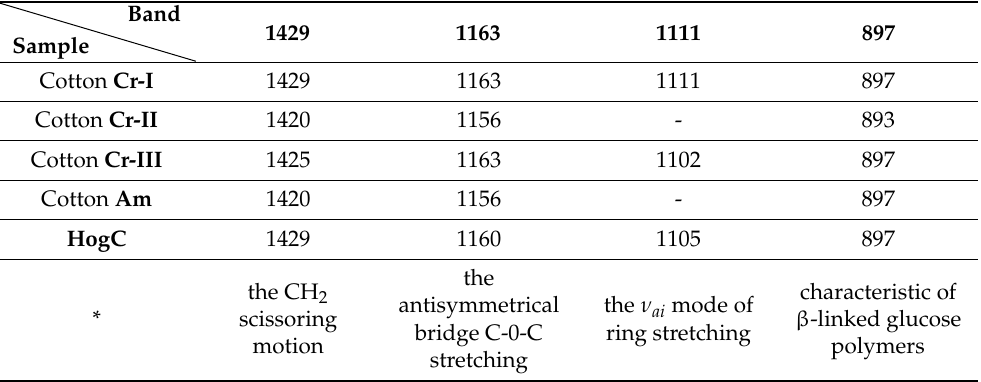
Table 3. Frequencies of some absorption bands (in cm − 1 ) in the IR spectra of native cotton (Cr-I), Fortisan (Cr-II), and cotton cellulose III (Cr-III), vibratory ball-milled cotton (Am), and cellulose, isolated by us from the crushed stalks of hogweed ( HogC ). Samples Cr-I, Cr-II, Cr-III, and Am were obtained and characterized in [20]. Band 1429 Sample